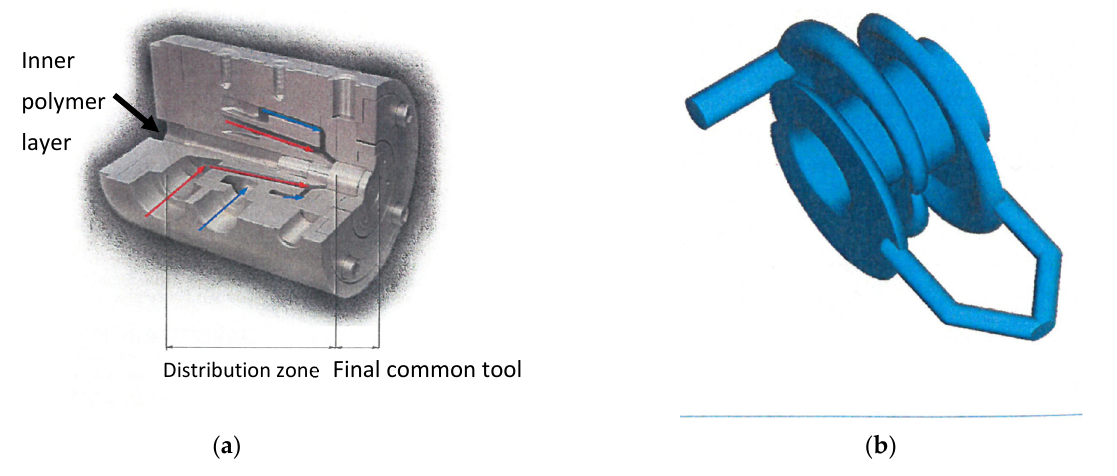
Figure 5. Geometry of the tube coextrusion die: ( a ) sectional view of the die; ( b ) unrolled “coat-hangers”. Reprinted with permission from Ref. [4]. Copyright 2009 É ditions Techniques de l’Ing é